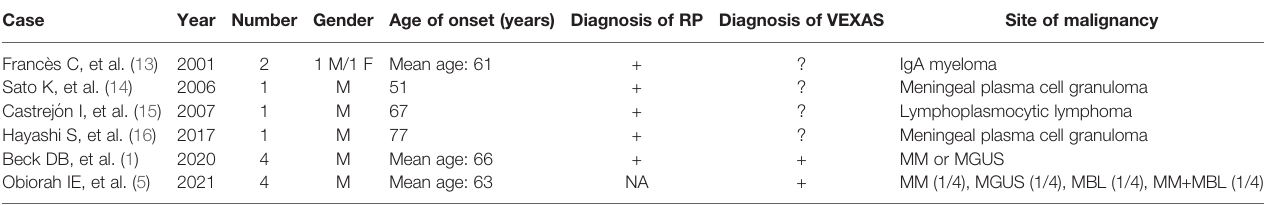
TABLE 1 | B-cell or plasma cell neoplasms in patients with auricular chondritis or VEXAS syndrome.